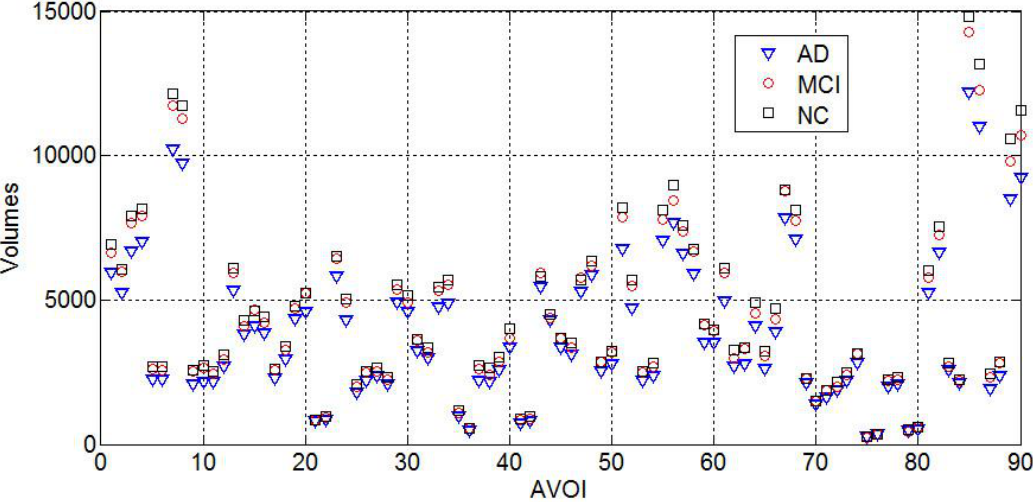
Figure 5. Mean of grey matter volumes of 90 anatomical volumes of interest (AVOI).